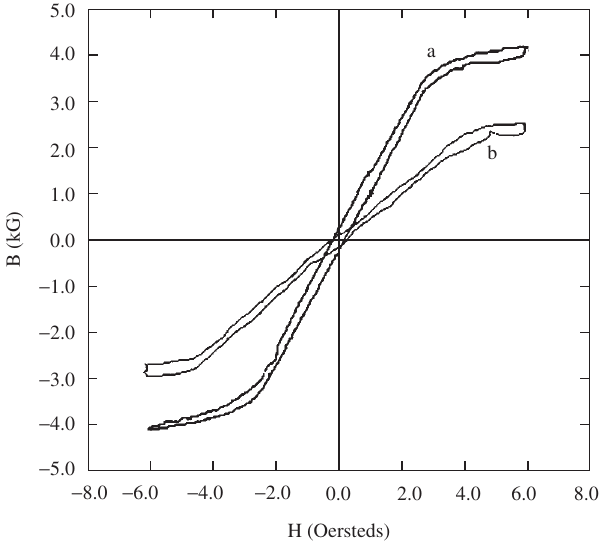
Figure 2. Hysteresis curves of the as-cast samples c and d. with Nylon and Titanium supports, respectively, at a frequency of 10